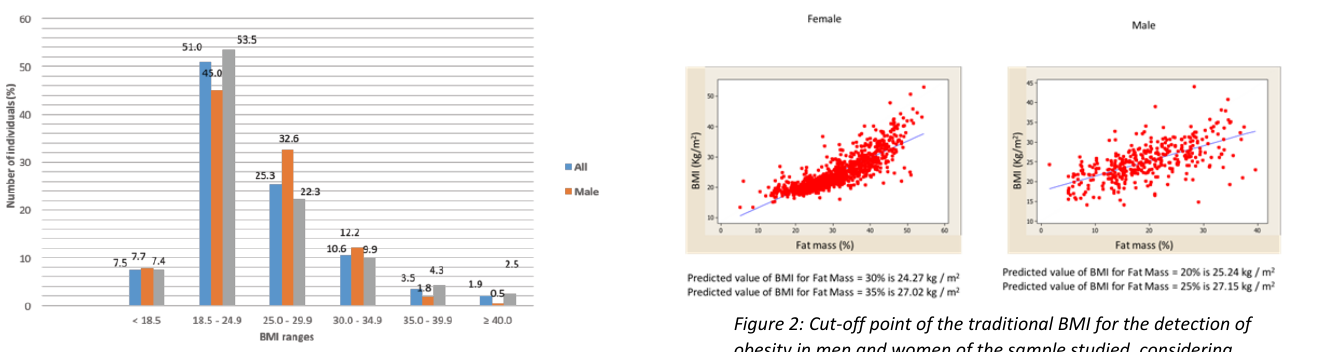
Figure 1: Subject distribution (%) according to the ranges of classification of nutritional status proposed by the body mass index (kg/m 2 ) and divided by gender. Table 2: Correspondence between the cutoff points of the BMI (kg/m 2 ) and body fat ranges (%) according to Gallagher et al (2000). BMI (kg/m 2 )